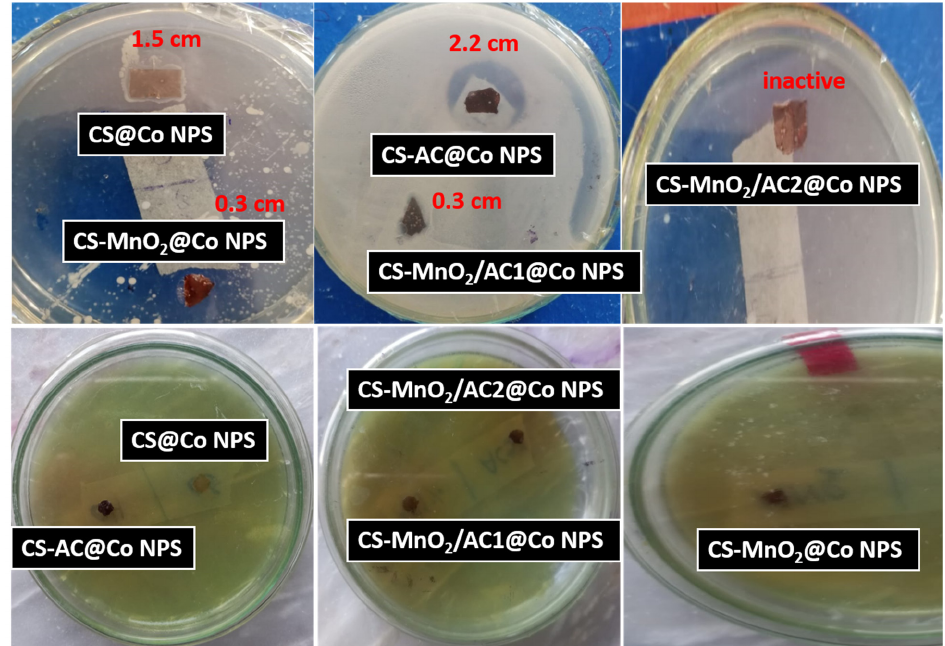
Figure 3. Antibacterial activity of all the catalysts against P. aeruginosa ( upper row ) and E. coli ( lower row ).